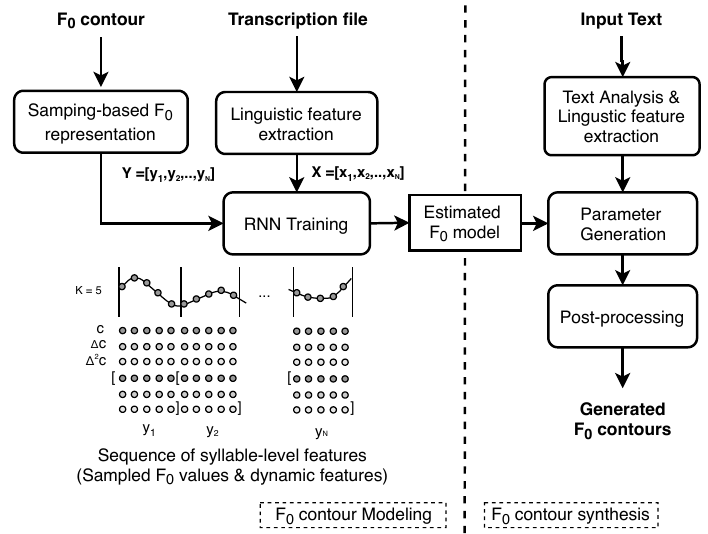
Figure 3. An overview of the proposed F 0